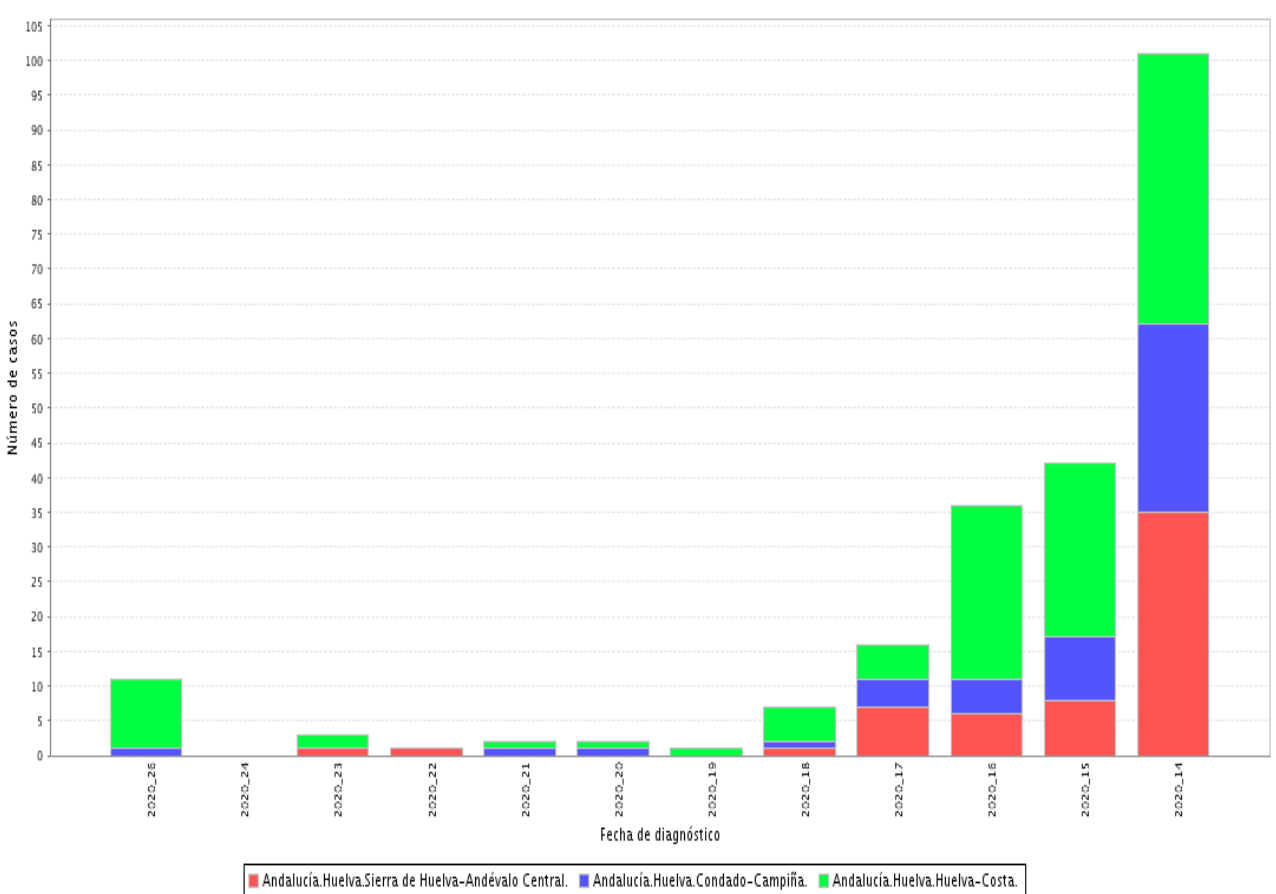
Figure 1. SARS-CoV-2 cases in the districts of the province of Huelva grouped by weeks [15].